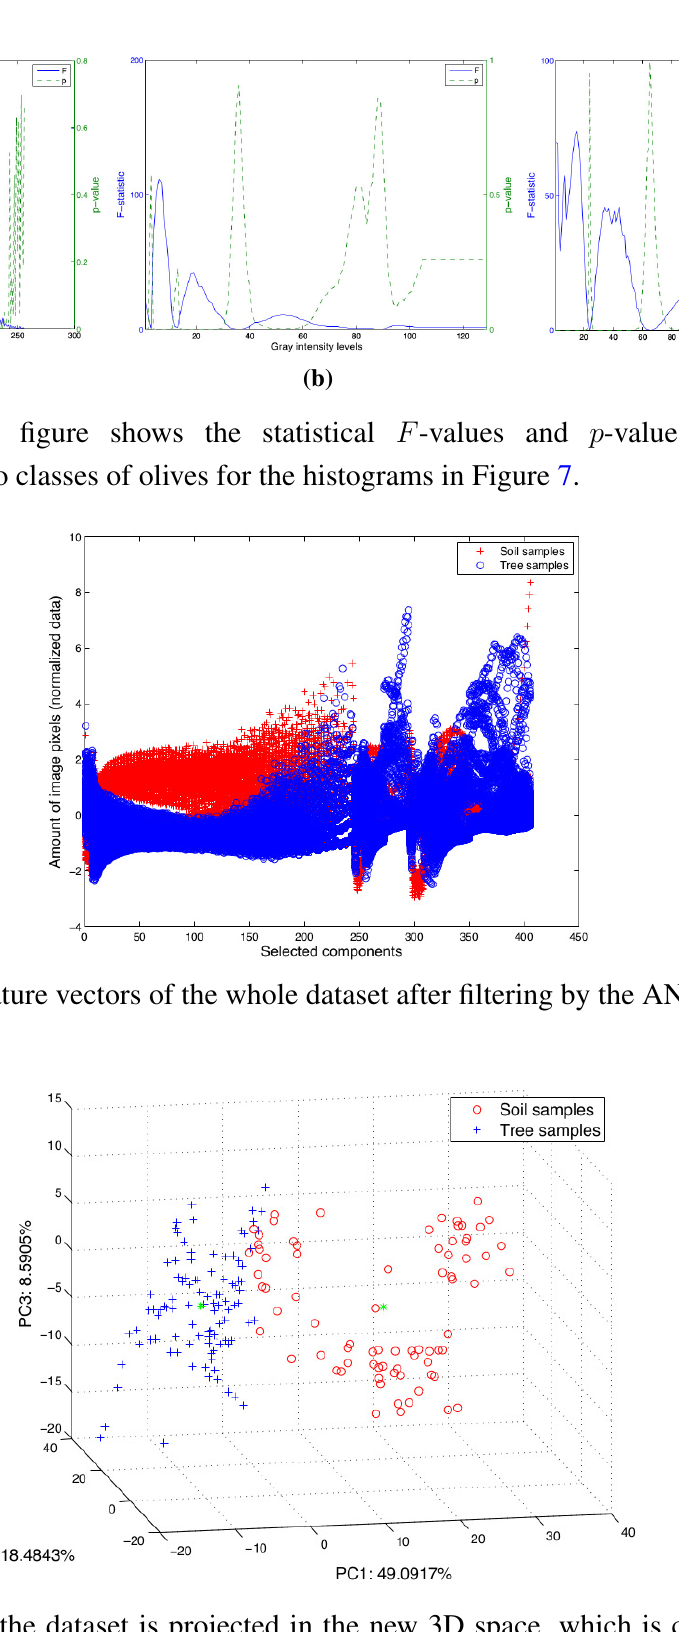
Figure 10. All of the dataset is projected in the new 3D space, which is created by three principal components, PC1, PC2 and